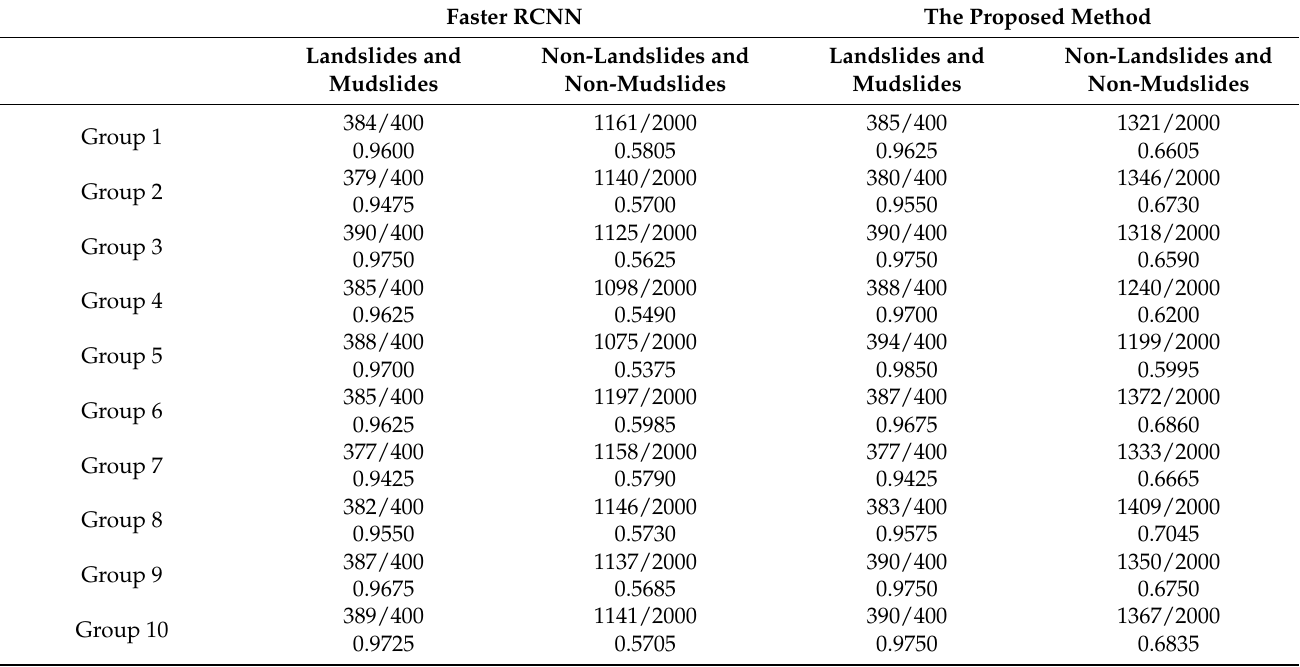
Table 2. Detection results for landslides and mudslides and non-landslides and non-mudslides. Faster RCNN The Proposed Method Landslides